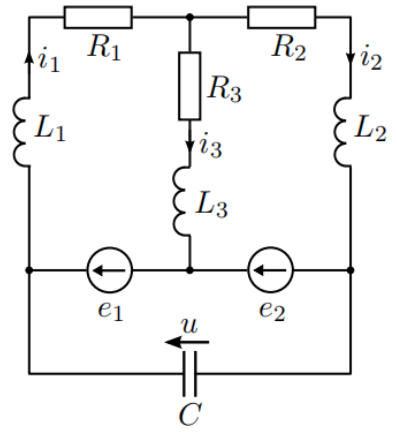
Figure 1. Electronic